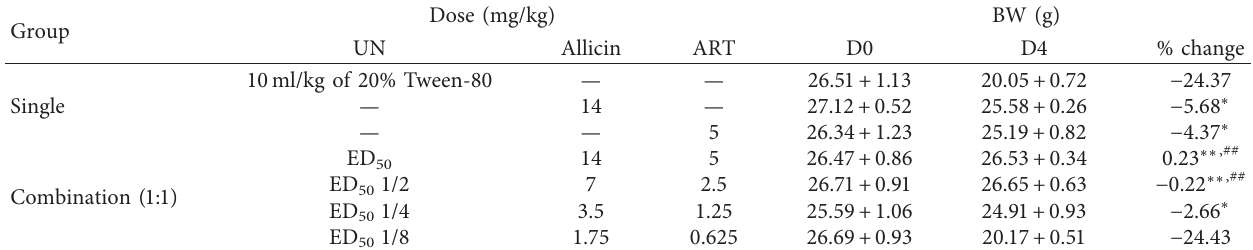
Table 3: Effect of allicin and its combination with ART on BW in PbANKA infection in mice. Group